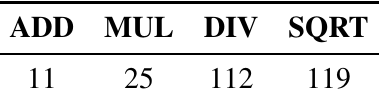
Table 4. Operation cycle